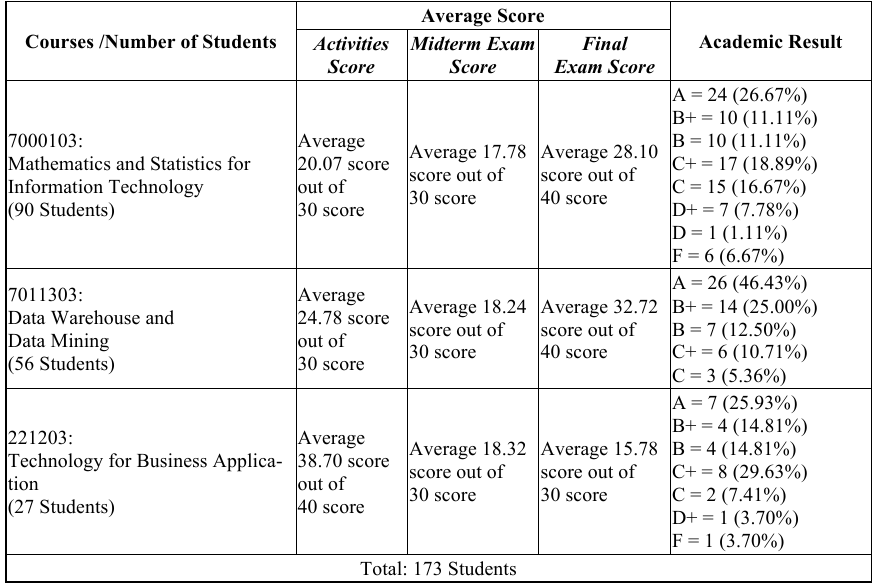
Table 2. Data collected during the first semester of the academic year 2020 Courses /Number of